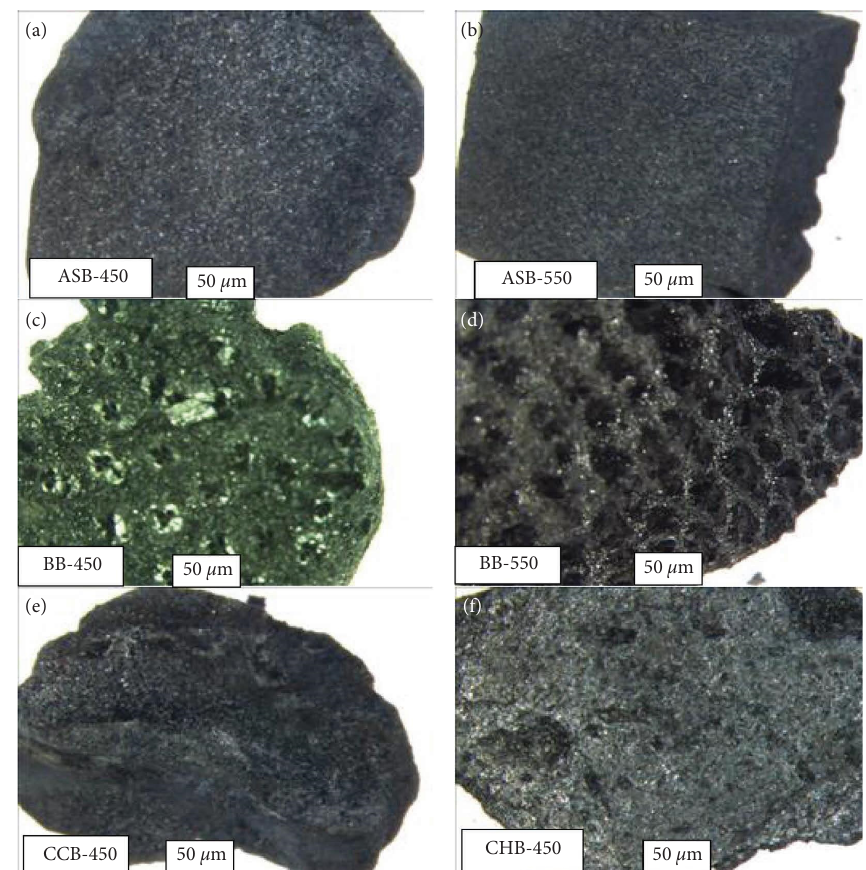
Figure 3: Image of scanned biochars. (a) Avocado seed biochar pyrolyzed at 450 ° C, (b) avocado seed biochar pyrolyzed at 550 ° C, (c) bamboo biochar pyrolyzed at 450 ° C. (d) bamboo biochar pyrolyzed at 550 ° C. (e) corncob biochar pyrolyzed at 450 ° C, and (f) cofee husk biochar pyrolyzed at 450 °